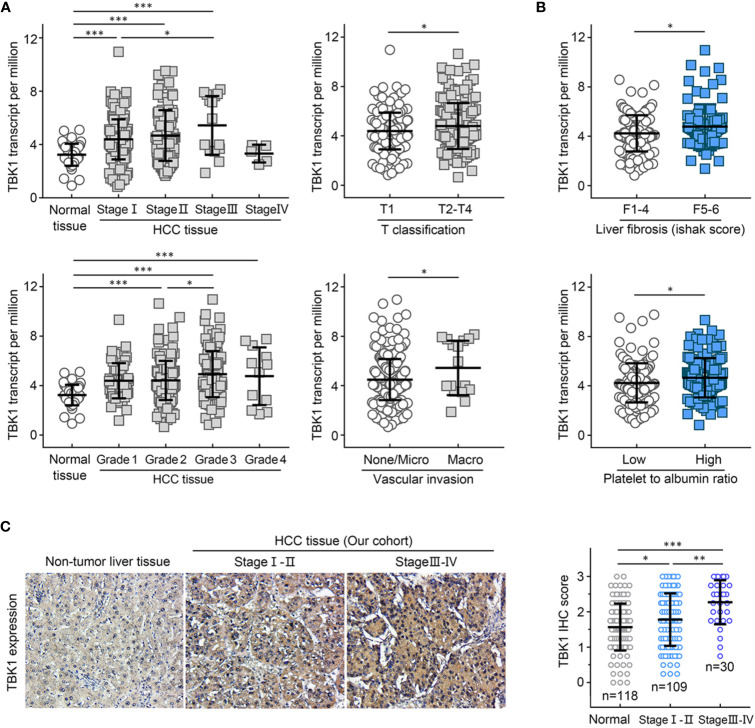
TANK-binding kinase 1 (TBK1) expression was associated with clinicopathological characteristics of patients with hepatocellular carcinoma (HCC). The HCC data set from The Cancer Genome Atlas (TCGA) was used to analyze the levels of TBK1 expression based on the clinical parameters of HCC (TNM stage, grade, T classification, and vascular invasion) (A), and inflammation indicators of patients with HCC (liver fibrosis and platelet-to-albumin ratio) (B). (C) The expression levels of TBK1 in different stages of patients with HCC from the present cohort (n=139). *P < 0.05; **P < 0.01; ***P < 0.001.